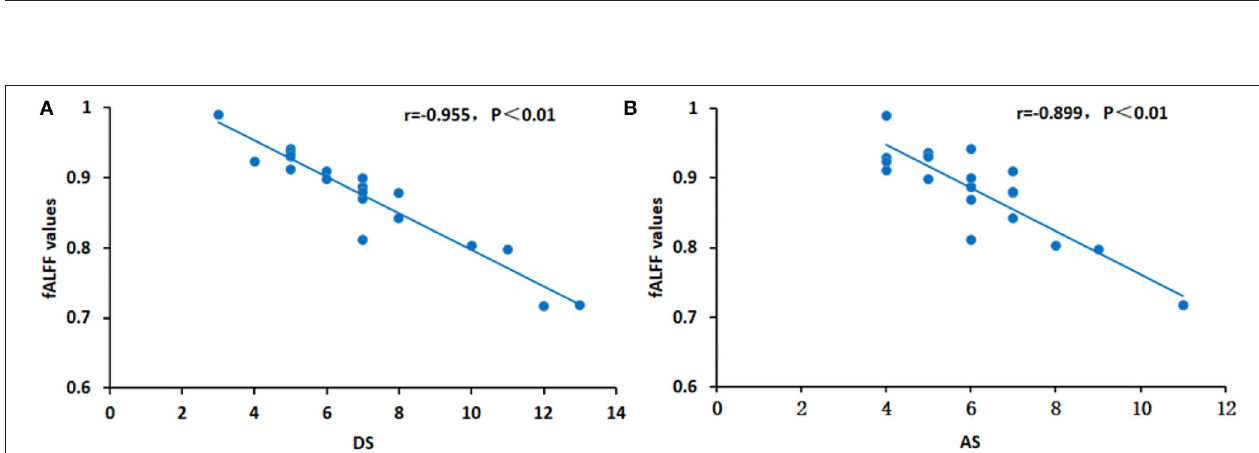
FIGURE 4 | Correlations between the average fALFF values and clinical characteristics in the RSTG. In the RSTG, the DS (r = − 0.955, p < 0.01) (A) and AS (r = − 0.899, p < 0.01) (B) are both represented by a negative relationship with the fALFF values. fALFF, fractional amplitude of low-frequency fluctuation; DS, depression score; AS, anxiety score; RSTG, right superior temporal